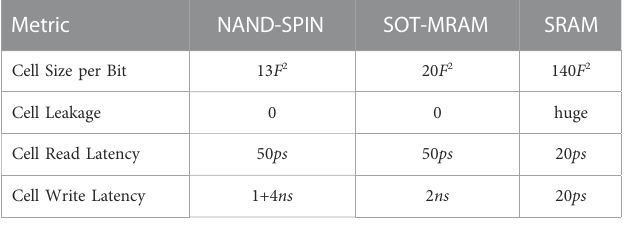
TABLE 2 The comparison of various memory technologies.